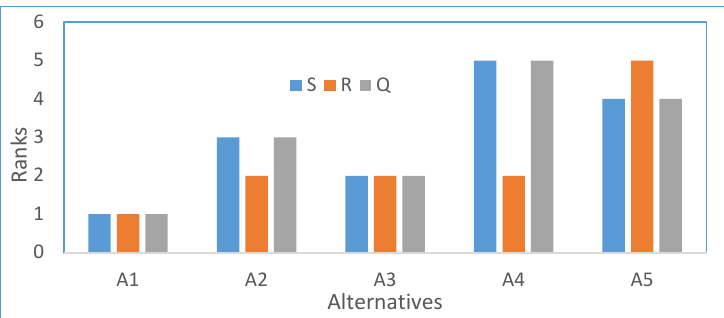
Fig. 3. The ranking of measures in ascending order by S, R and